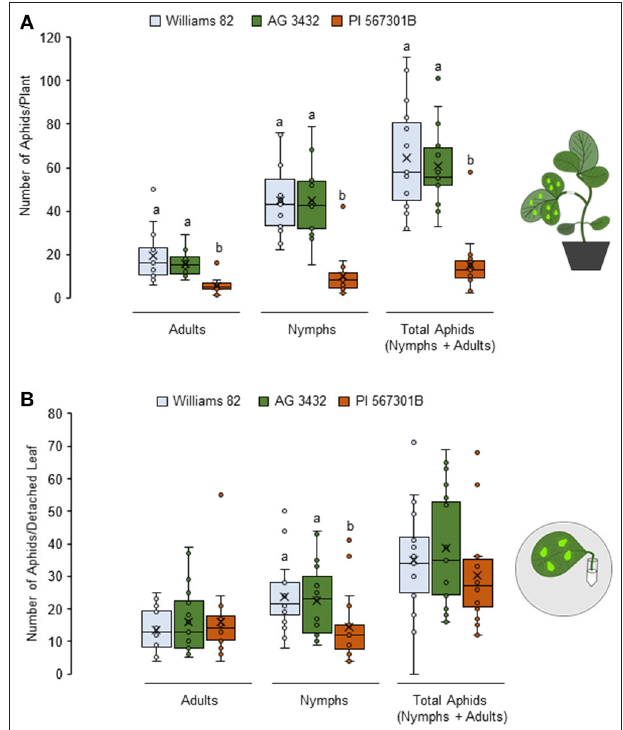
FIGURE 1 | Rag5 -mediated resistance to soybean aphids is lost in detached leaves. (A) Population of soybean aphids (total number of nymphs and apterous adults) on whole plants and (B) detached leaves of Williams 82, AG34332, and PI 567301B. The numbers of adults and nymphs were recorded daily for 4 days, and data for day 4 are shown. Three replications are performed for each genotype, and the experiment is repeated three times. Different letters above the bars indicate values that are significantly different. The cartoons represent the setup of the whole plant and detached leaf assays. Aphid size and number in the cartoons are not drawn to